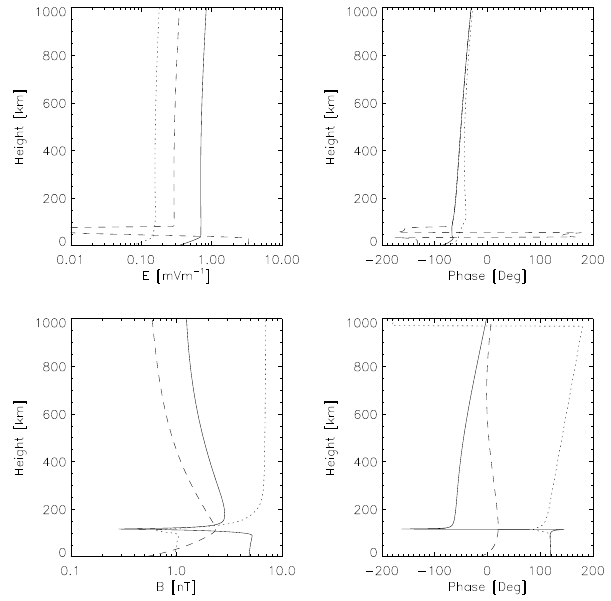
Fig. 2. ULF wave fields at L=2.4 for local midday winter (North Hemisphere). The solid lines are the X (north-south), the dotted lines are the Y (east-west) and the dashed lines are the Z (vertical) ULF field components. The parameters for the ULF wave model were f =15mHz, k x = 3 . 5 × 10 − 6 m − 1 , k y = 7 . 0 × 10 − 7 m − 1 with an incident shear Alfv´en mode at 1000km